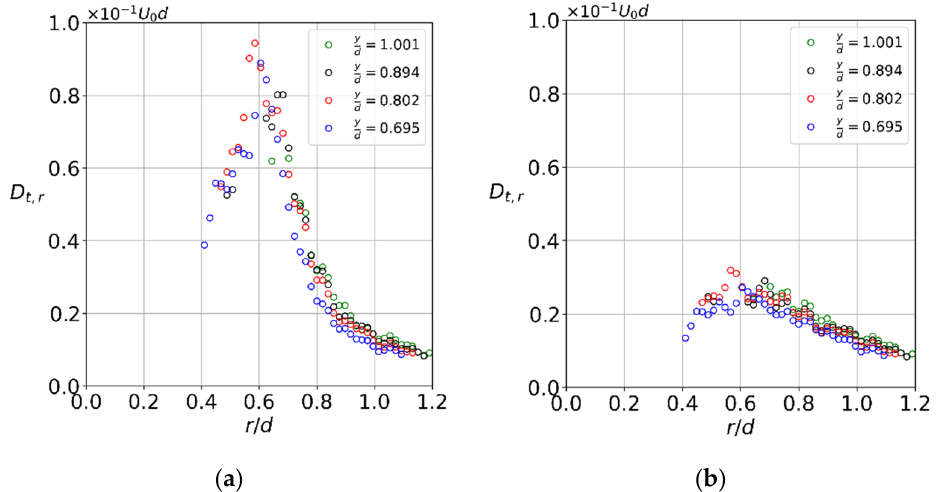
Figure 14. Turbulent diffusion coefficient for ( a ) total and ( b ) stochastic turbulent fluctuations for high-swirl